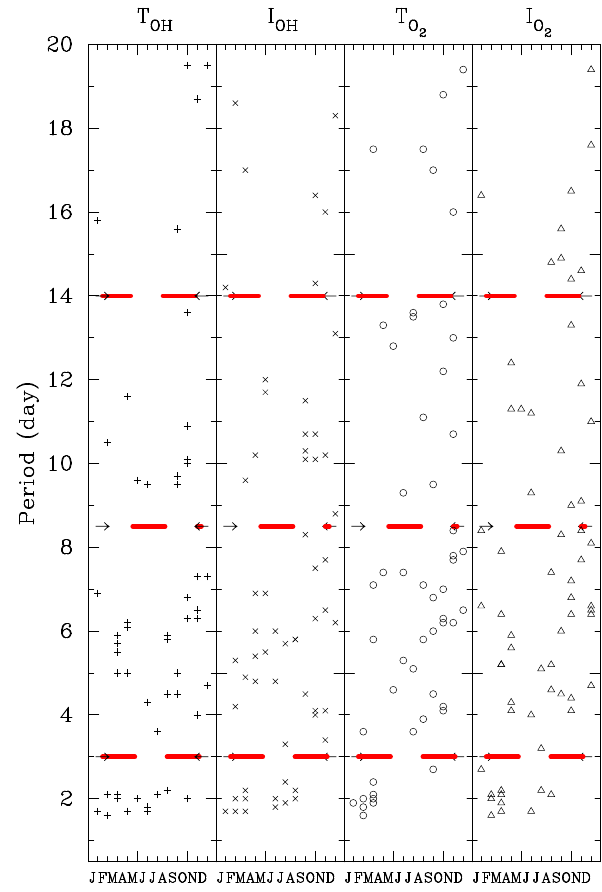
Fig. 3. Periods of possible wave oscillations detected in the whole set of measurements. Dashed lines: limits between the period re- gions